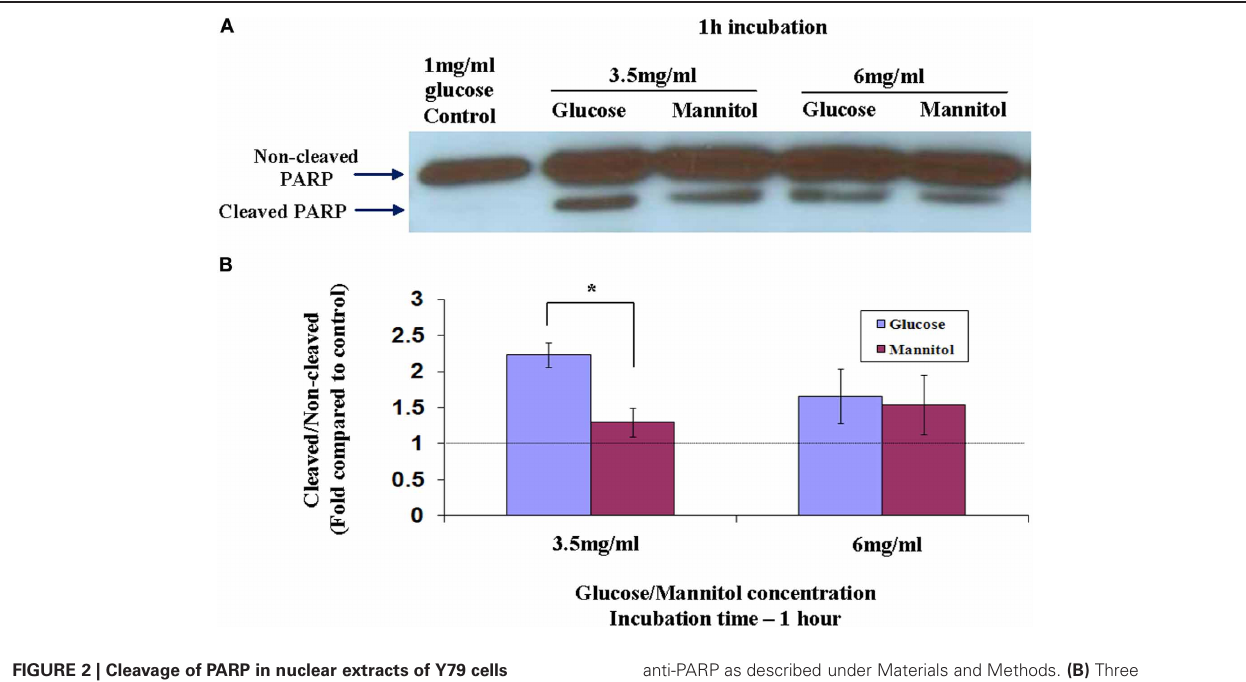
FIGURE 2 | Cleavage of PARP in nuclear extracts of Y79 cells treated by adding glucose or mannitol. Y79 cells were incubated for 16–24h in starvation medium (1% FBS and 1mg/ml glucose), and then glucose or mannitol was added (except in control) to reach a concentration of 3.5mg/ml or 6mg/ml and incubated for 1 or 2h. (A) Nuclear extracts were prepared and run on SDS-PAGE, blotted, and probed with